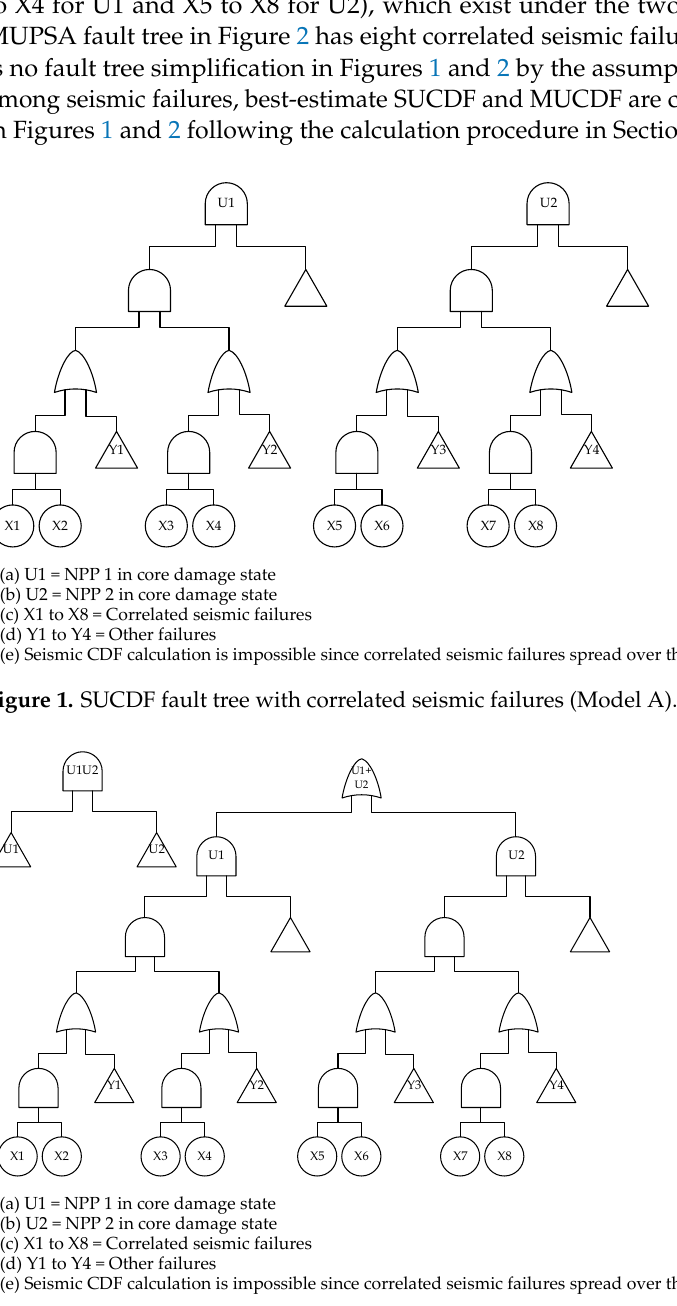
Figure 2. MUCDF and SCDF fault trees with correlated seismic failures (Model A).